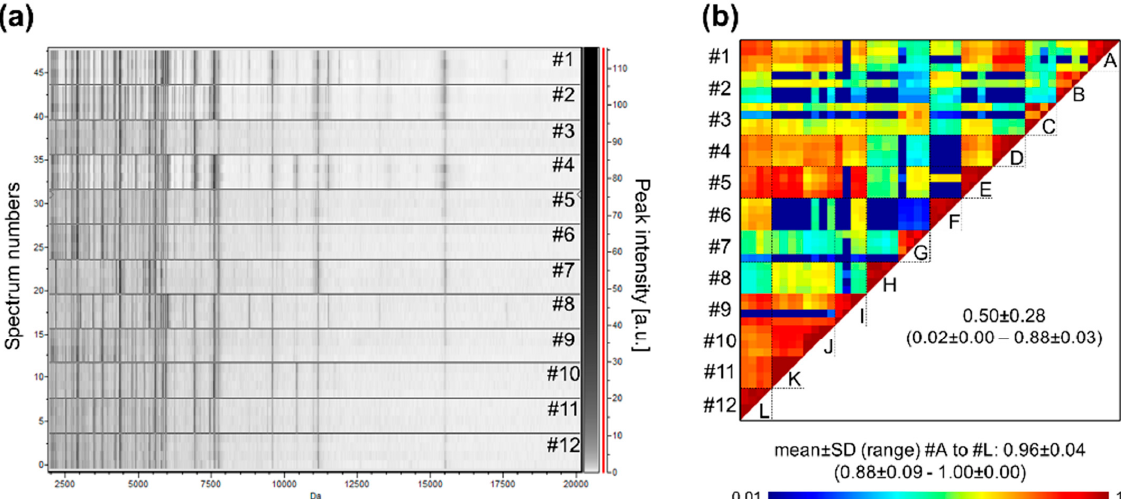
Figure 7. Saliva MS profiles from 12 healthcare workers. ( a ) Gel view of saliva MS spectra from 12 distinct individuals. The four replicates loaded on the MS plate for each individual per are presented. ( b ) Composite correlation index (CCI) matrix representing the levels of MS spectra reproducibility between individuals. The values correspond to the mean coefficient correlation and respective standard deviations obtained for paired condition comparisons. CCI are expressed as the mean ± standard deviation. #1 to #12: healthcare workers. A to L: assessment of individual MS spectra reproducibility.